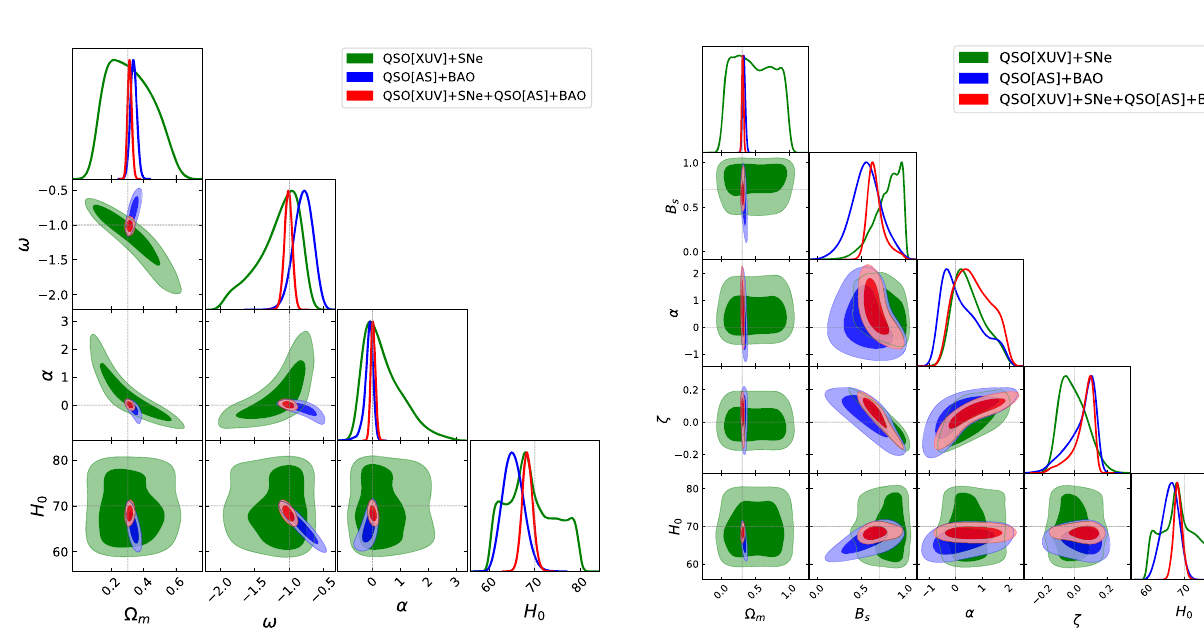
Fig. 4 The 1D and 2D probability distributions of model parameters in the NGCG model